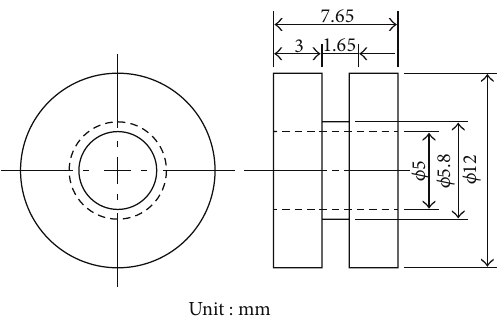
Figure 1: Schematic of shearing test specimens.